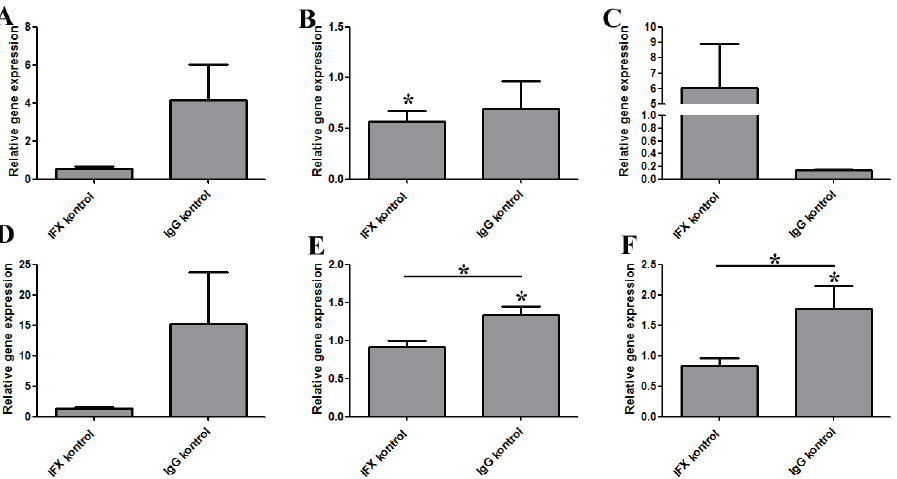
Figure 7. IFX-elicited reverse signaling had a marginal effect in the absence of inflammatory conditions. Naïve bone marrow-derived mouse macrophages were treated with IFX, IgG, or left unstimulated. Relative gene expression of TNF ( A ), IL-1 β ( B ), PDCD1 ( C ), CXCL9 ( D ), CXCL10 ( E ), and ICAM-1 ( F ) was determined 48 h after IFX or IgG stimulation. Bars show the average ± SEM from at least three independent experiments. * Significantly different (One-Way ANOVA, following Neuman–Keuls post hoc